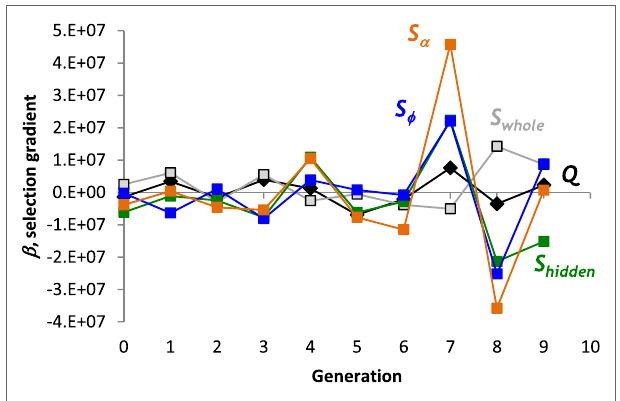
FigUre 8 | selection gradients, β , for structural properties of the ann . The largest positive and negative selection gradients occur in generation 7 and 8, respectively, for sparsity, S , of the projections from the hidden layer to offset and frequency output nodes. Linear, directional selection gradients measure the effect of each trait on fitness. Scaled coefficients allow comparisons among different